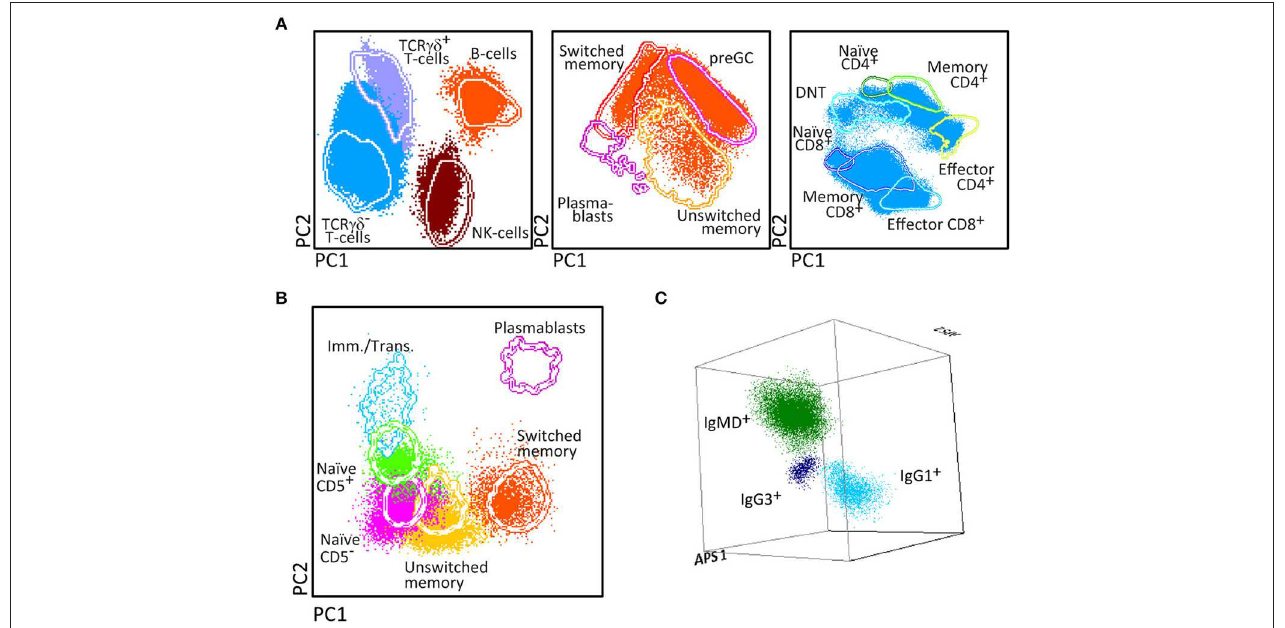
FIGURE 8 | PCA representation of the biologically relevant subsets in a patient diagnosed with IgG2 subclass deficiency with IgA deficiency (40 years). The distribution of the biologically relevant PB lymphocyte subsets has been represented using multidimensional reference plots. The supervised analysis of the PID orientation tube using PC1 vs. PC2 reference plots (A) shows that plasmablasts were undetectable in the patient sample after acquiring 1 × 10 6 cells. Lack of plasma cells was confirmed in the analysis of the Pre-GC and Post-GC B-cell tubes (B) . In addition, three dimensional PCA representation of IgH-isotype subsets in memory B-cells (C) showed that although the counts of total switched memory B-cells was normal in the previous tubes, the subsets of IgG2 + , IgA1 + , and IgA2 + were undetectable with a sensitivity of 10 cells in a mL of peripheral blood (0.01 cells/ µ L).